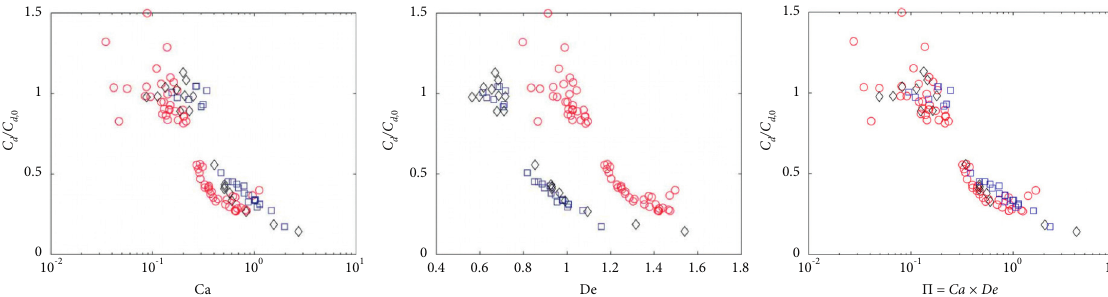
Figure 13: Normalized drag coefficient as a function of Ca, De, and Π